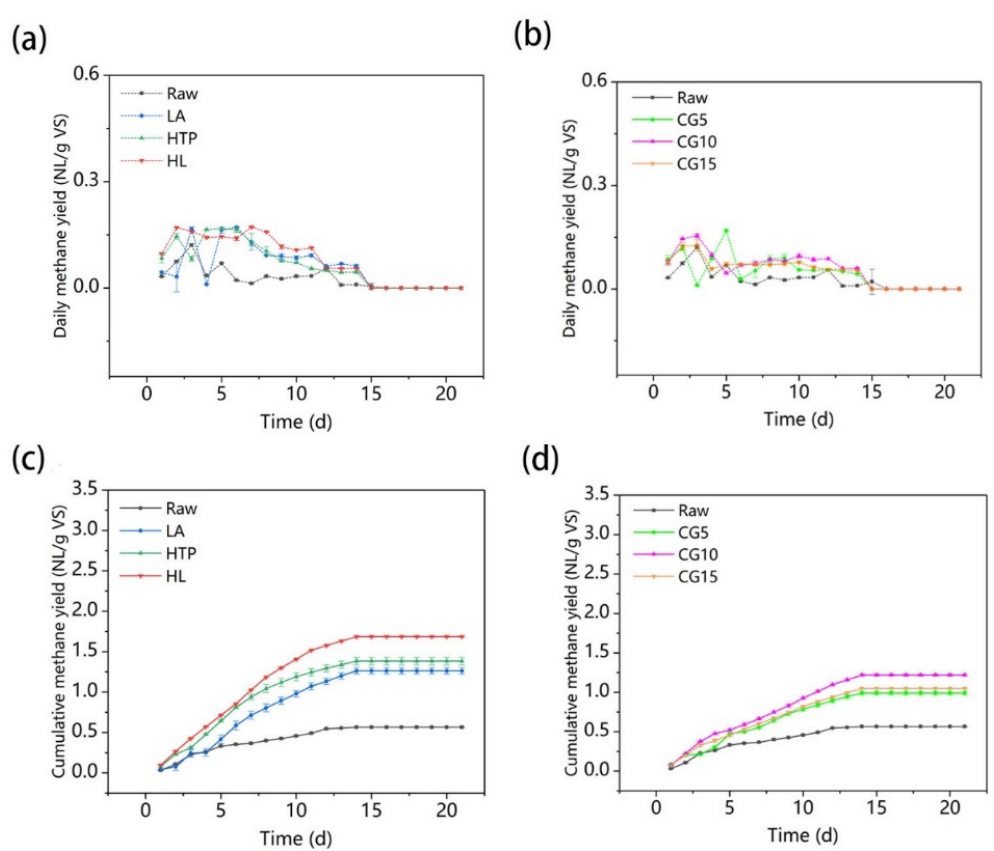
Figure 1. Daily methane yield: ( a ) LA, HTP, and HL pretreated FW groups; ( b ) FW co-digestion with 5, 10, and 15% CG) and cumulative methane yield: ( c ) LA, HTP, and HL pretreated FW groups; ( d ) FW co-digestion with 5, 10, and 15% CG). Table 5. VS input , VS output , and VS removed values of all experimental